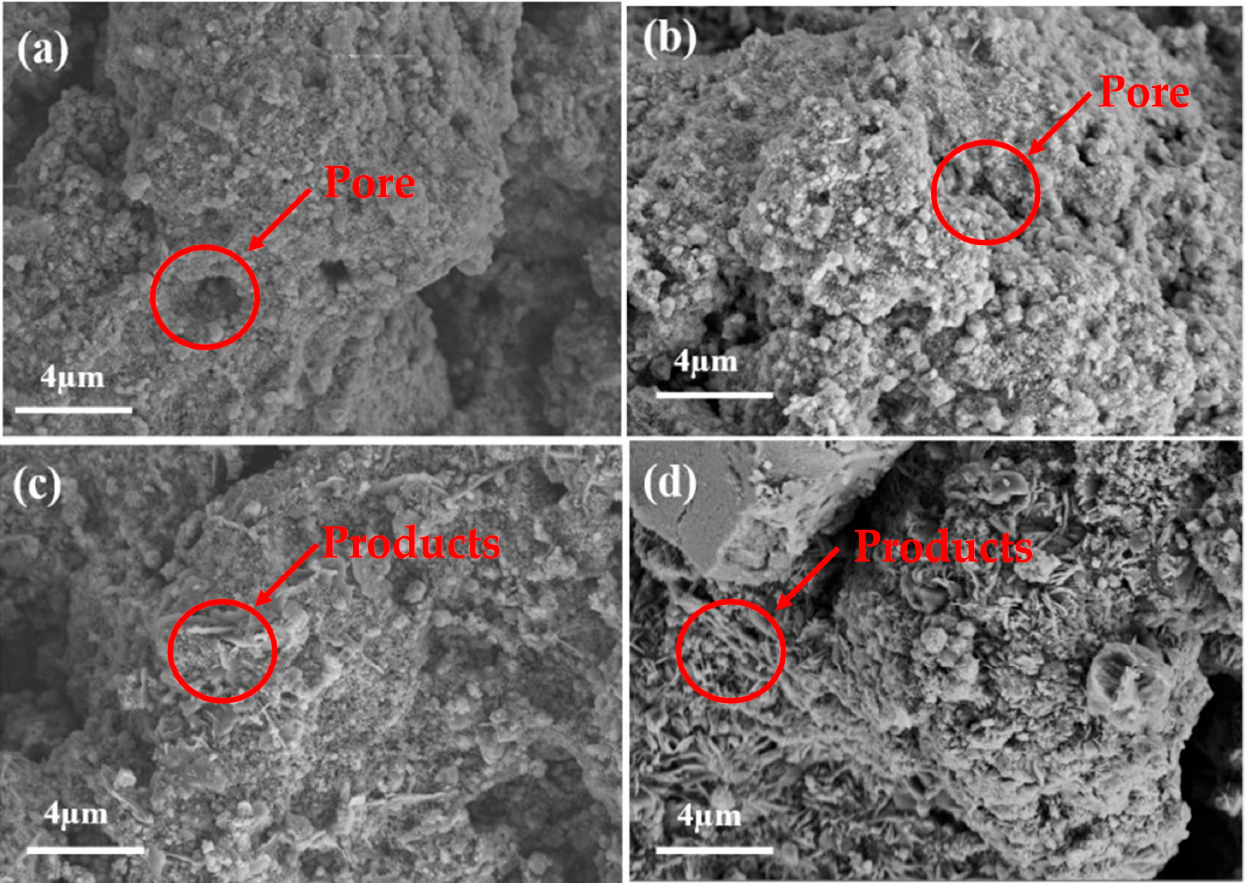
Figure 10. Surface morphology of adsorbent: ( a ) original desulfurization; ( b ) 2.5%; ( c ) 5.5%; ( d ) 7.5%. Table 3. BET and pore structure parameters of desulfurization products with different CO 2 con ‐ centrations.